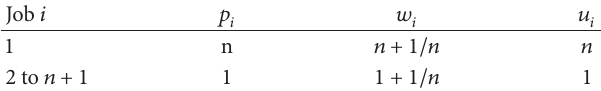
Table 3: Jobs’ parameters in Example